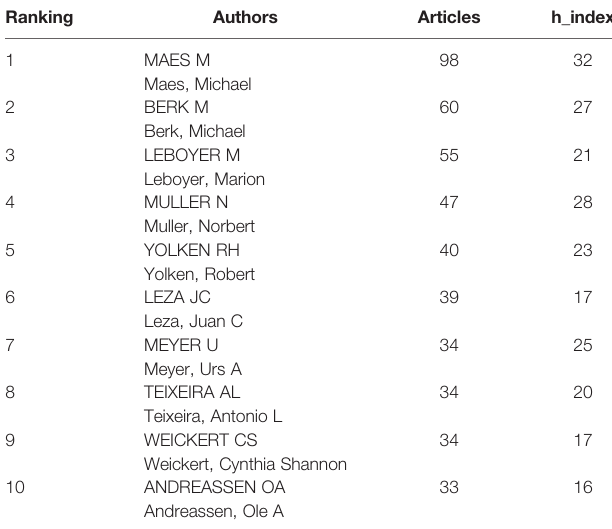
TABLE 2 | Top 10 authors with the most publications in the fi eld of schizophrenia and in fl ammation